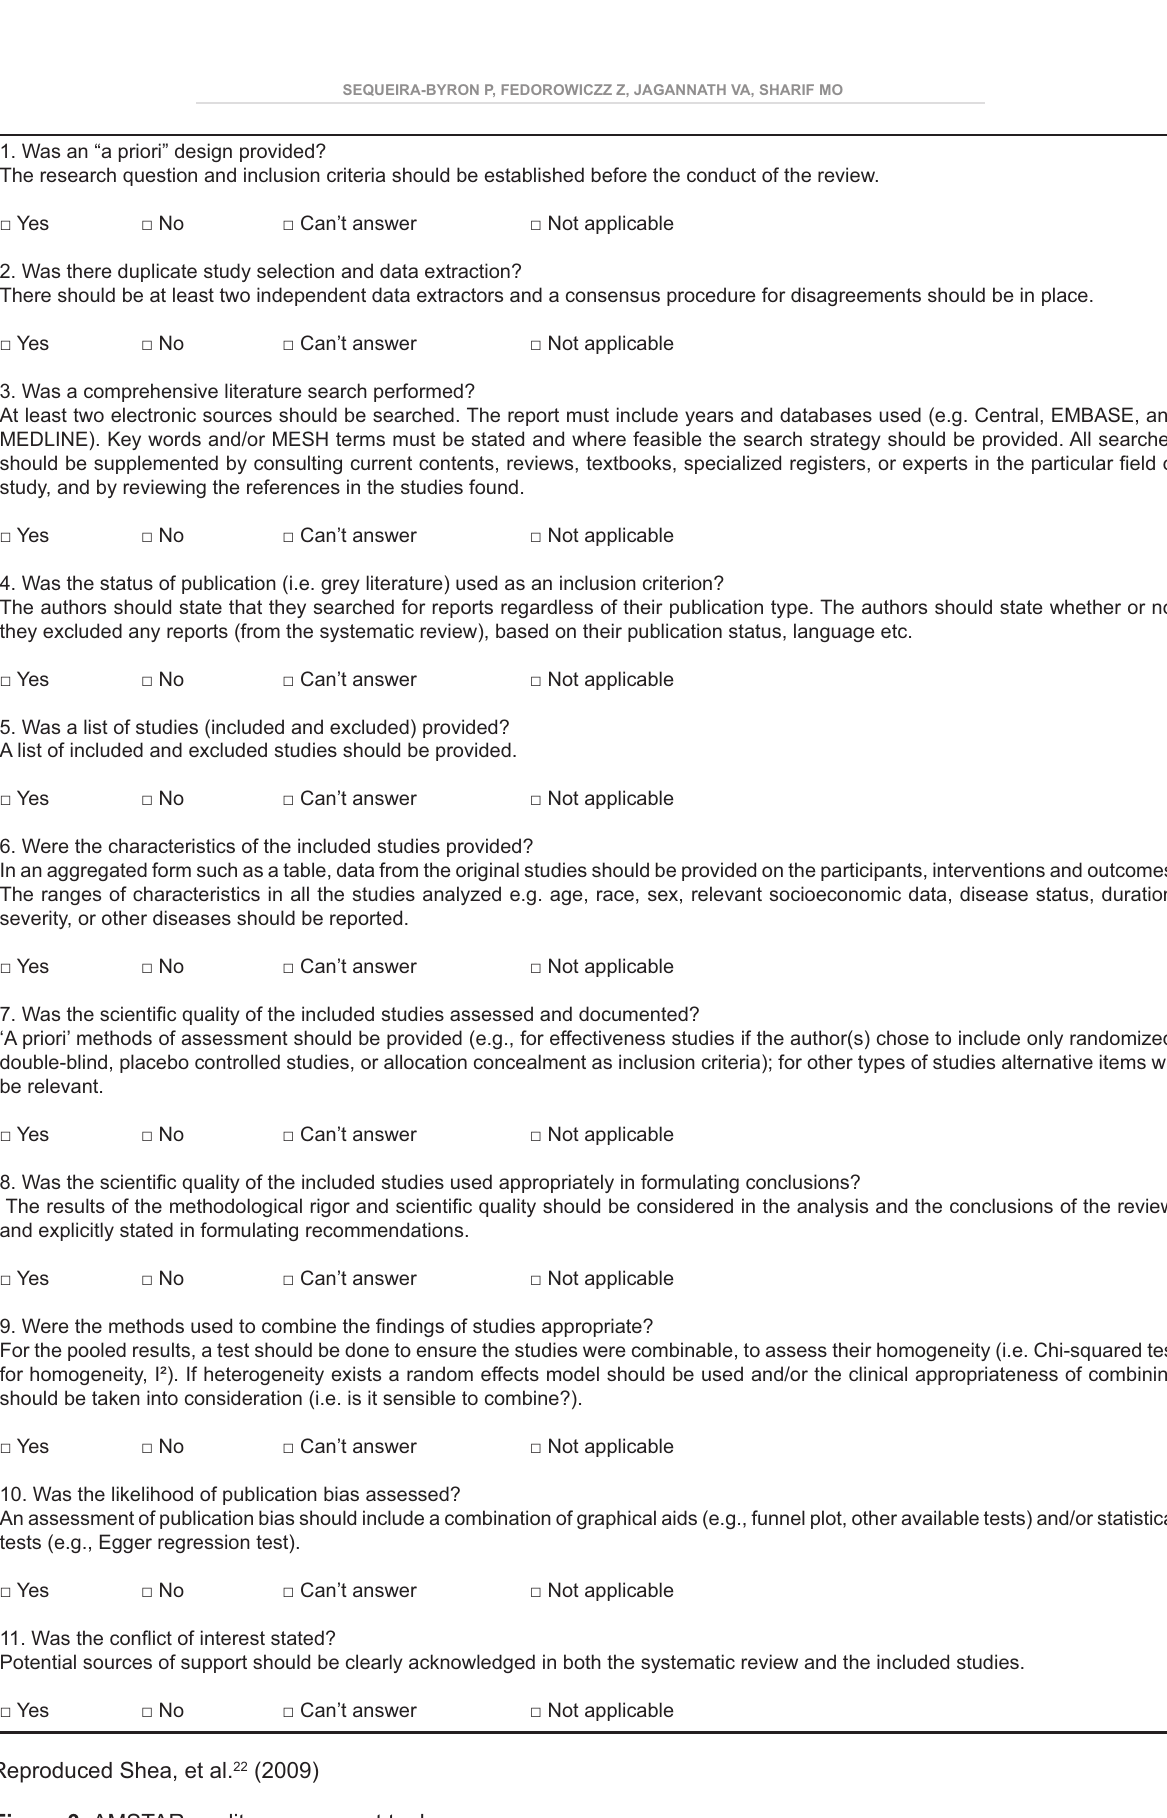
Figure 3- AMSTAR quality